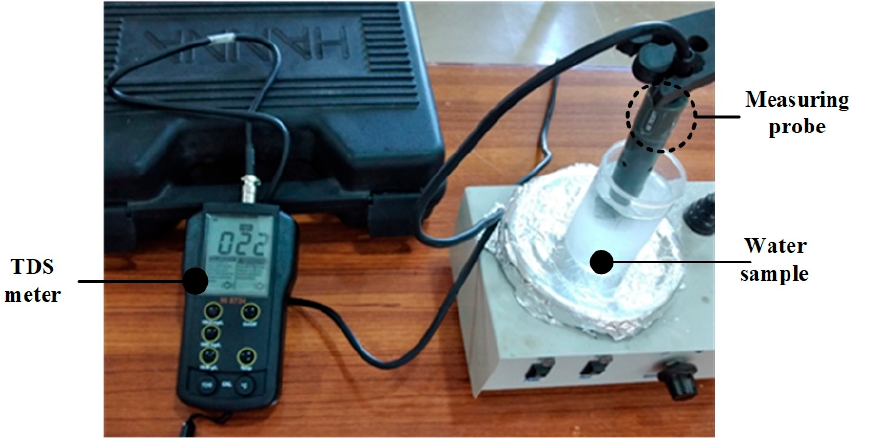
Figure 6. Total dissolved solids (TDS) measuring kit.